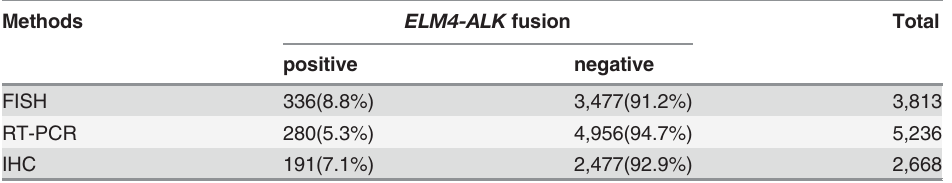
Table 2. The detecting methods of the EML4-ALK fusion